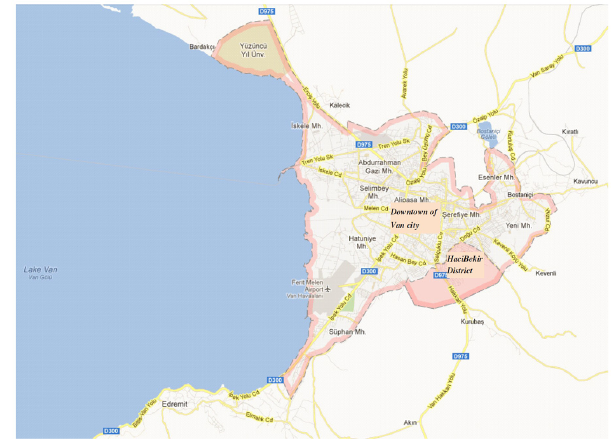
Fig. 8. Locations of Van city and the Hacibekir